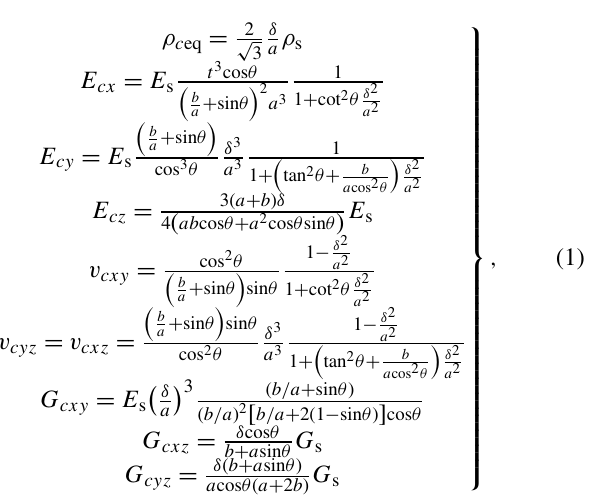
Figure 3. Effect of the core height on the natural frequencies of the honeycomb panel; the abbreviations ELM, HM, and IAM represent the dynamically equivalent modeling method based on the lami- nated plate theory, the single-layer plate equivalent method based on the Hoff (1948) theory, and the improved Allen (1969) equiva- lent